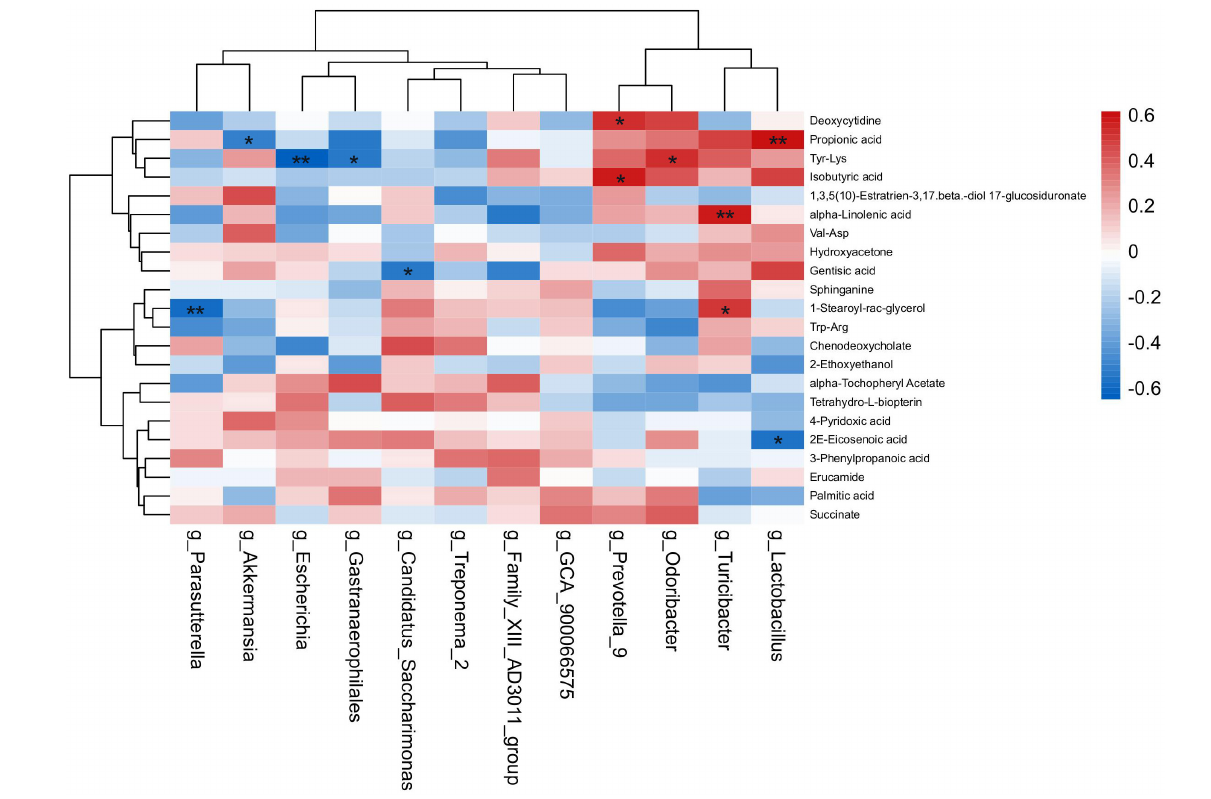
FIGURE 9 | Correlation analysis of the intestinal microbiota and metabolites. Spearman’s rank correlation between eight most differential genera and 22 differential metabolites. * P < 0.05, ** P < 0.01 denoted statistical significance between microbiota and